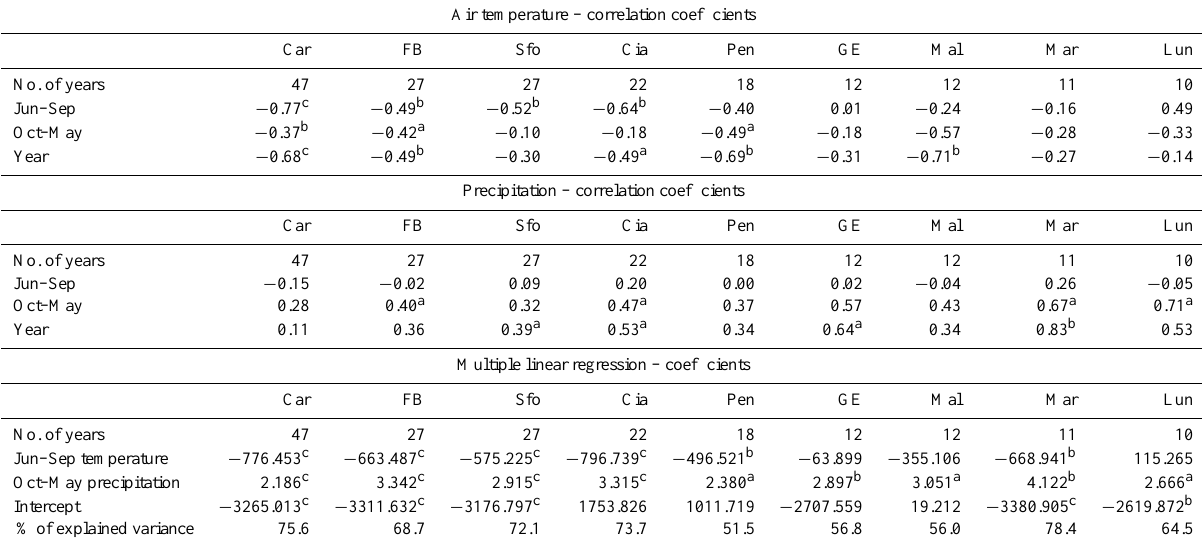
Table 6. Spearman correlation coefficients and multiple regression results of B a versus seasonal mean temperature and